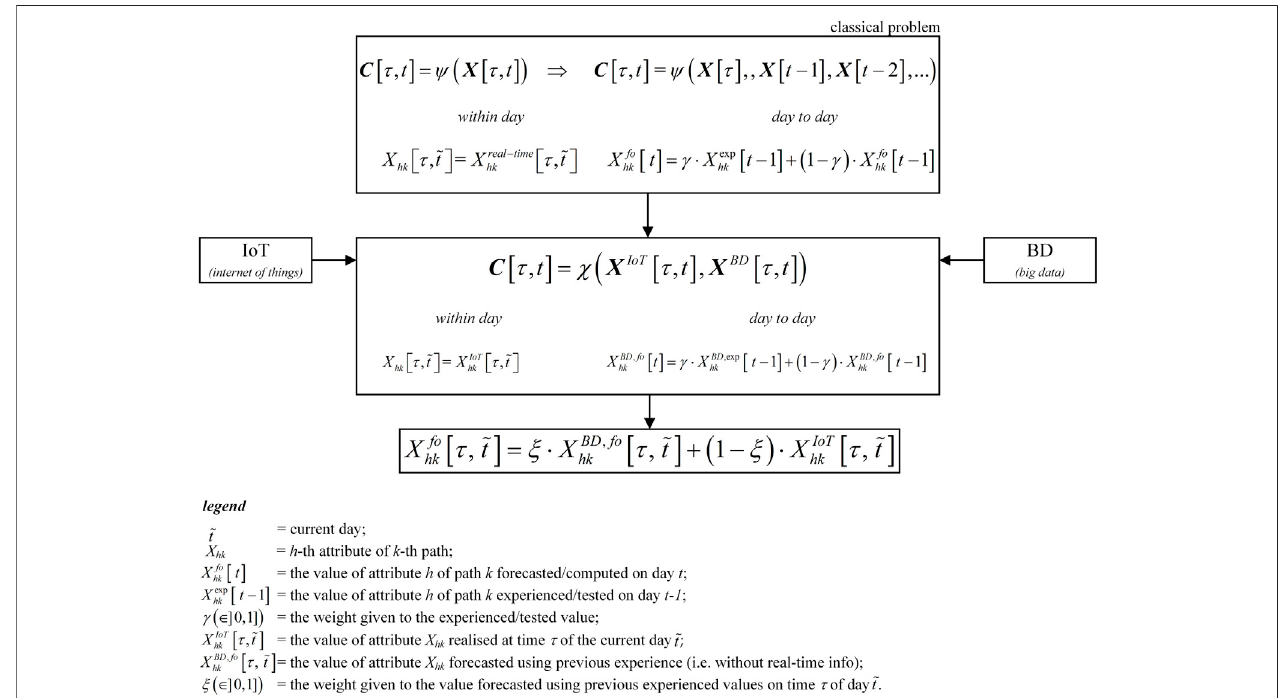
FIGURE 1 | Learning process of path attributes enhanced by emerging technologies, IoT and BD (Russo and Comi, 2021).